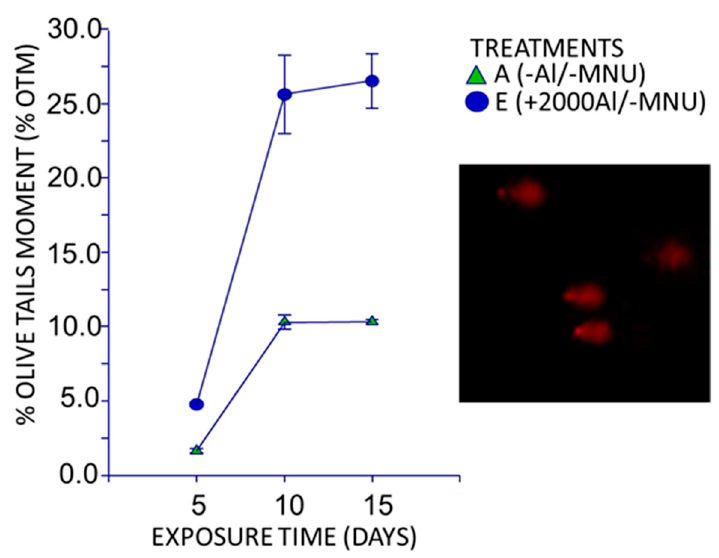
Figure 3. Genotoxic effect caused by the +2000Al/-NMU treatment in the peripheral blood of Sprague Dawley rats at 5, 10, and 15 days of exposure, evaluated by the comet test.